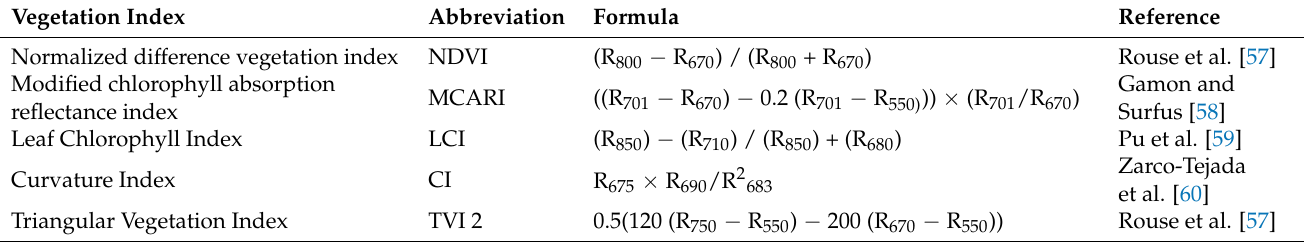
Table 3. The spectral reflectance indices (SRI) involved in the lysimeter experiment in the 2019/20